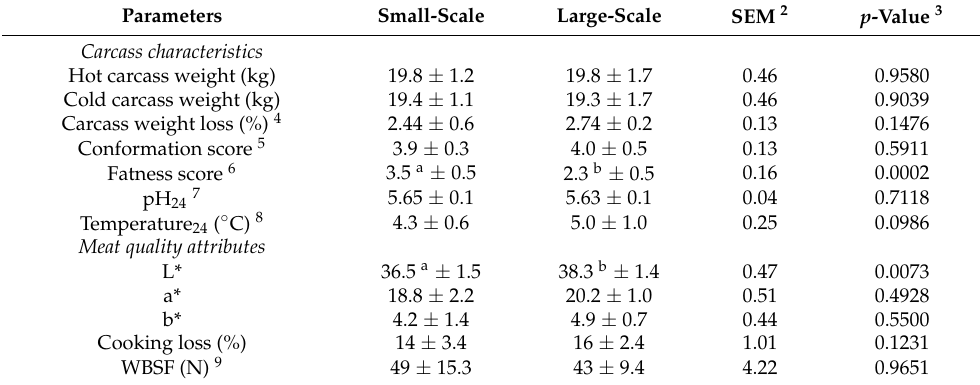
Table 1. Carcass characteristics, pH 24h , temperature 24 , colour measurements and cooking loss of lamb slaughtered in the small-scale system ( n = 10) and large-scale system ( n = 10/ n = 8 1 ; means ±